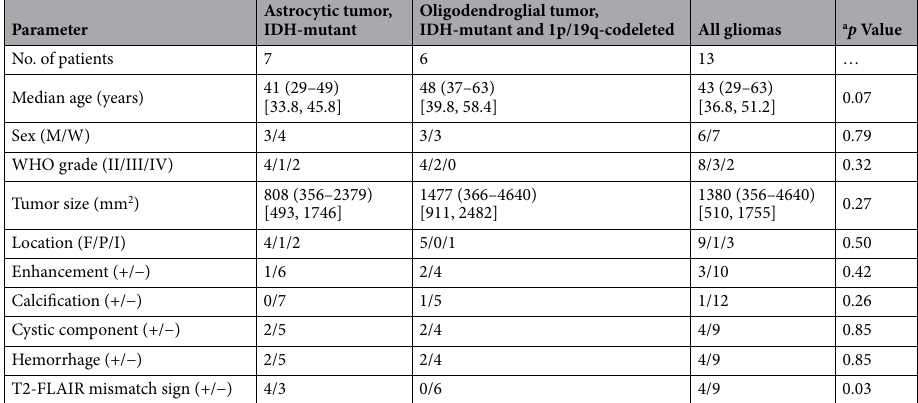
Table 1. Patient demographics and characteristics. Data in parentheses are the range, and data in brackets are the interquartile range. 1p/19q-codeleted = deletion of the short arm of chromosome 1 and long arm of chromosome 19, F = frontal lobe, I = insula, FLAIR = fluid-attenuated inversion recovery, IDH = isocitrate dehydrogenase, M = men, P = parietal lobe, W = women, WHO = World Health Organization. a Chi-square